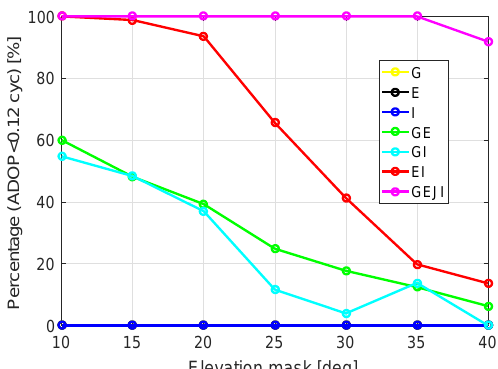
Figure 6. Percentages within a 24 h period that ADOP is smaller than 0.12 cycles for baseline CUAA-CUCC on DOY 224, 2018. Note that the yellow and the black lines are overwritten by the blue line. The data sampling rate is 1 Hz. The yellow and black lines are overwritten by the blue line.